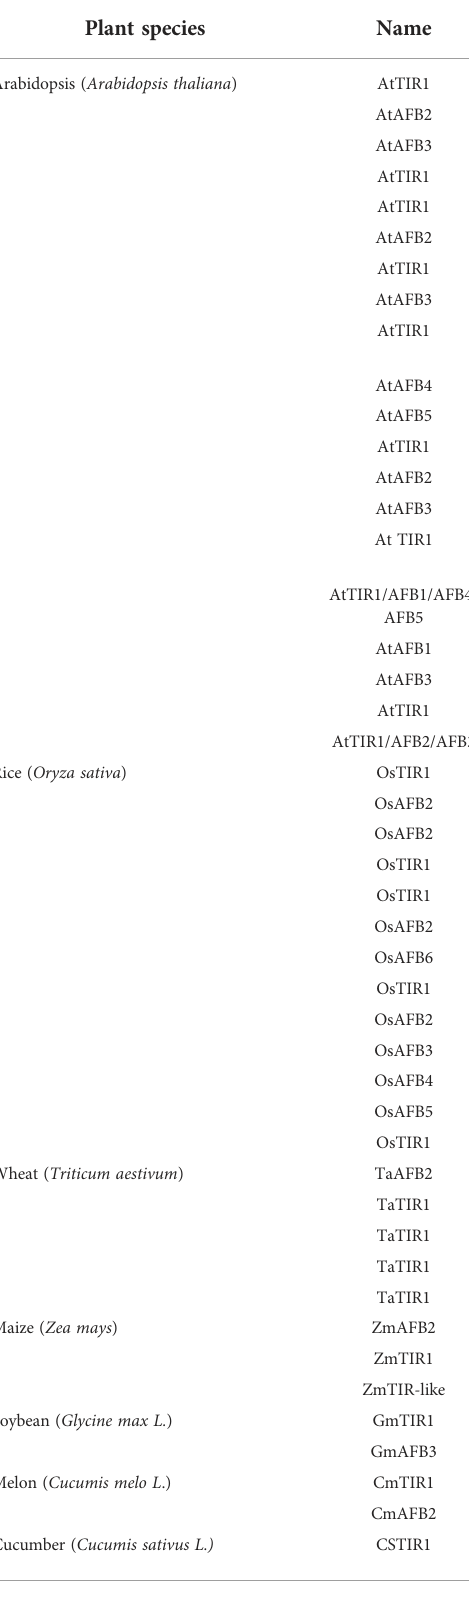
TABLE 1 TIR1/AFB proteins involved in abiotic and biotic stress in